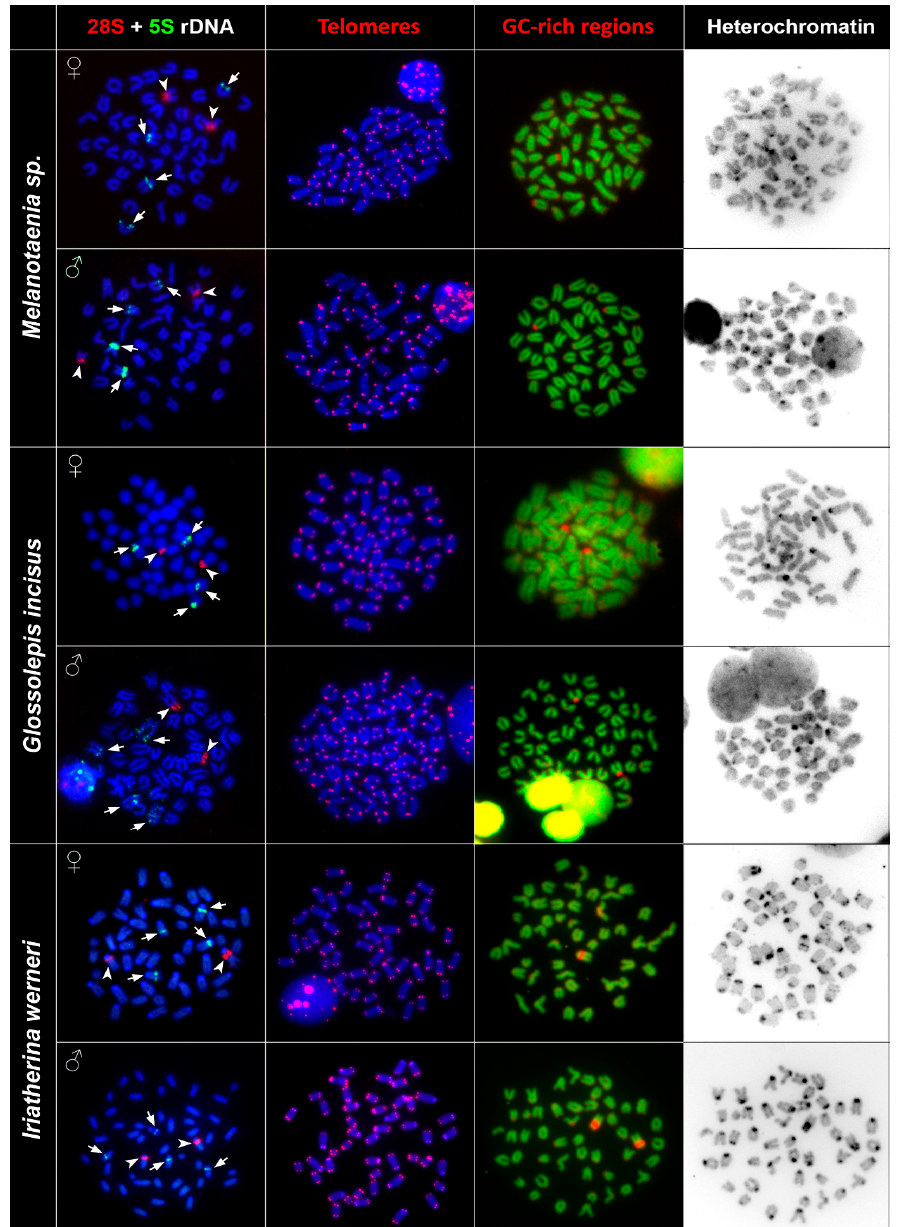
Figure 2. Comparative chromosome analyses of Melanotaenia sp., G. incisus , and I. werneri . First column: DAPI (4 ′ ,6-diamidino-2-phenylindole)-stained chromosomes (blue), 28S rDNA (red, indicated by arrowheads), 5S rDNA (green, indicated by arrows) hybridisation signals; second column: DAPI-stained metaphases (blue), telomere repeat hybridisation signals (red); third column: DAPI-stained metaphases (green), signals of GC-rich regions (red); fourth column: inverted DAPI- stained C banding pattern. Bar = 10 μ m.